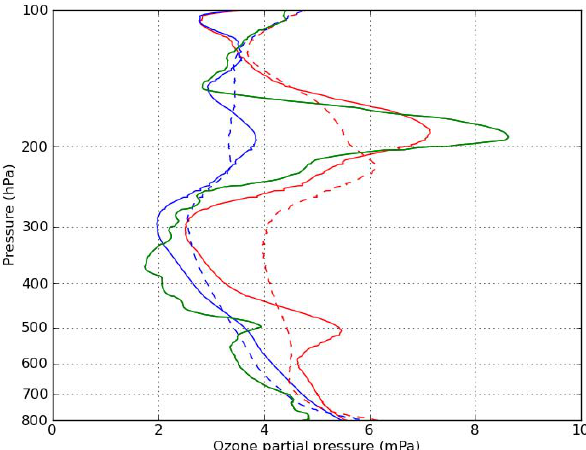
Fig. 10. Ozone profiles, mPa, from a sonde over Payerne (46.5 ◦ N, 6.6 ◦ E; green line, launched at 11:00UT on 17 July 2009), from the free MOCAGE run (blue lines) and from analyses (red lines). Low resolution (2 ◦ ) and high resolution (0.2 ◦ ) results are represented by dashed and solid lines,